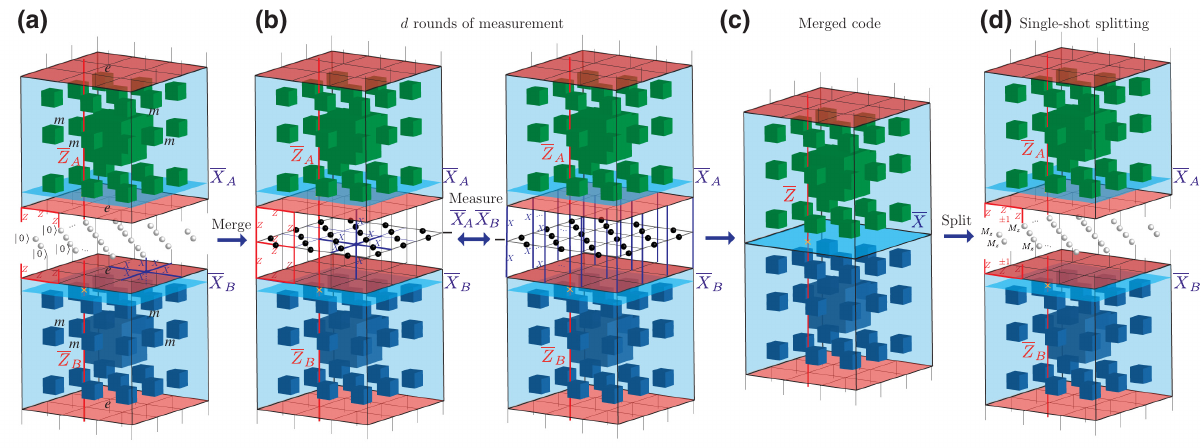
FIG. 32. The lattice-surgery protocol to transform the logical information inside one of the code copies within the coupled stack fractal code (top) to an ancilla fractal code block (bottom). (a) Initialization of the ancilla qubits (white balls) between the two codes in state | 0 (cid:8) . (b) Lattice merging via d rounds of syndrome measurement and subsequent decoding. Two types of new stabilizers are introduced at the interface: the four-body Z stabilizers (red) with + 1 eigenvalues and the six-body X stabilizers (blue) with unknown eigenvalues and hence a random ± 1 measurement outcome. The measurement outcome of the new interface X stabilizers equivalently gives the measurement outcome of the joint parity of logical operators: X A X B (supported on the highlighted blue vertical edges). (c) The merged code after d rounds of measurement. (d) The lattice-splitting protocol. The unknown stabilizers at the interface are the three-body Z stabilizers that have a random ± 1 measurement outcome, which can be inferred by the projective measurement of the ancilla qubits in the Z basis ( M Z ). The ( − 1 ) -eigenvalue corresponds to the m -loop excitations, which can be corrected with a single-shot decoding process even in the presence of measurement error.